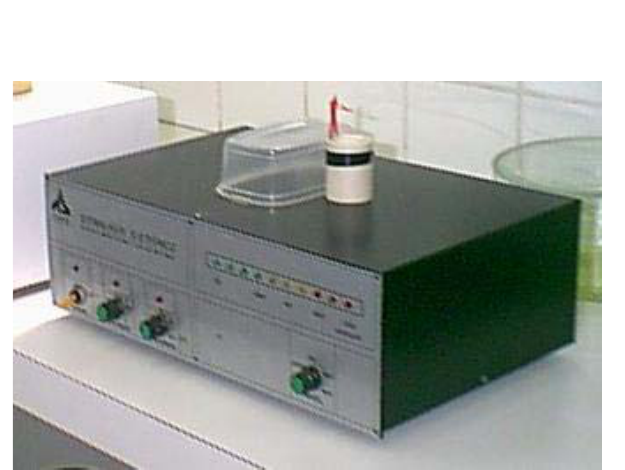
Figure 6. The equipment used for venom extraction. R. P.